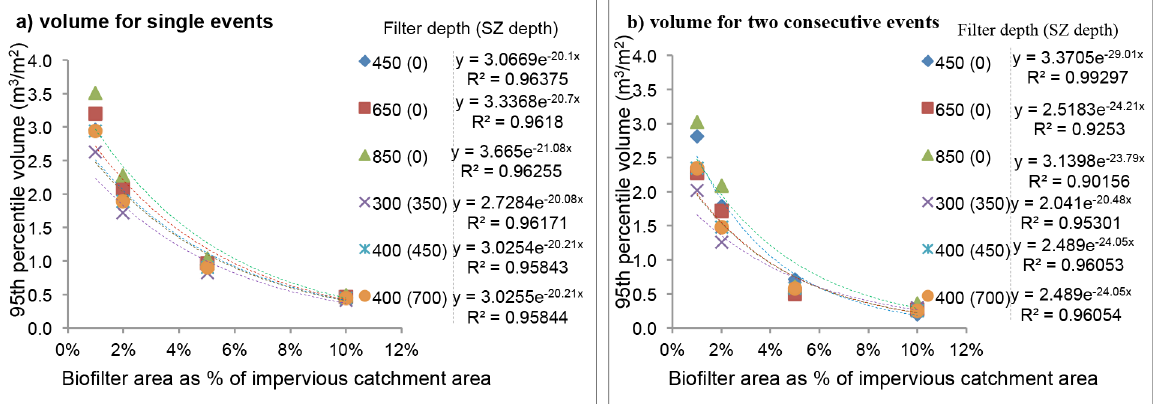
Fig 3. Plots of volume of water treated per area of biofilter as a function of biofilter area as percent of impervious catchment for Mediterranean climate (Perth) at the designed hydraulic conductivity 100 mm/h and extended detention depth 200 mm: a) 95 th percentile volume for single events and b) 95 th percentile volume for two consecutive events. SZ: submerged zone .